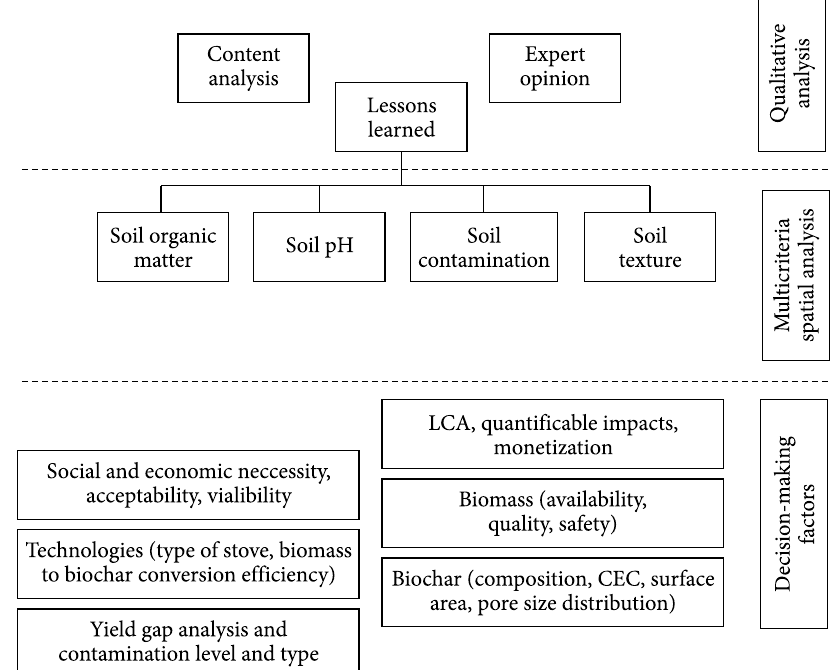
Fig. 2. Flowchart of the 3-step methodology to derive prioritization of biochar use for sustainable land management. First, the literature was reviewed to provide data input to spatial prioritization. In this study we used organic matter content, soil pH, soil texture and contamination level to arrive at the prioritization map. Subsequently we discuss other benefits of biochar and the most important practical considerations that must be taken into account before biochar is applied. Some considerations from the step 3 of this methodology could enrich spatial prioritization; their use however is subject to data availability (and therefore not included in this study)